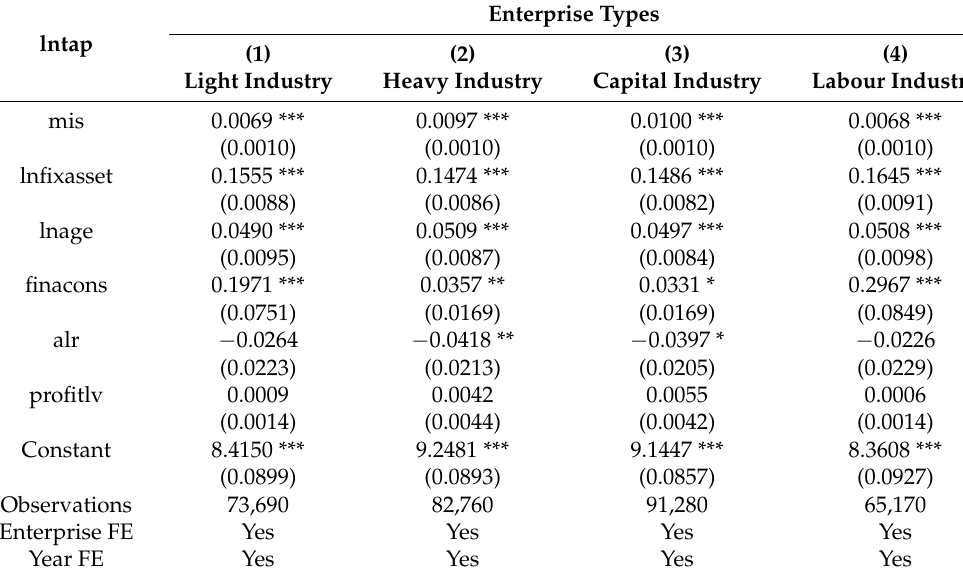
Table 9. Heterogeneity analysis of enterprise types.